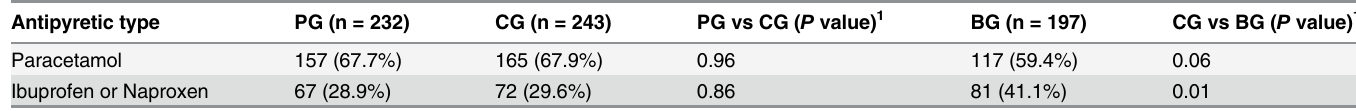
PG — Prebiotics Group; CG — Control Group; BG — Breast-fed Group Number and percentage of children per study group having received one or more doses of